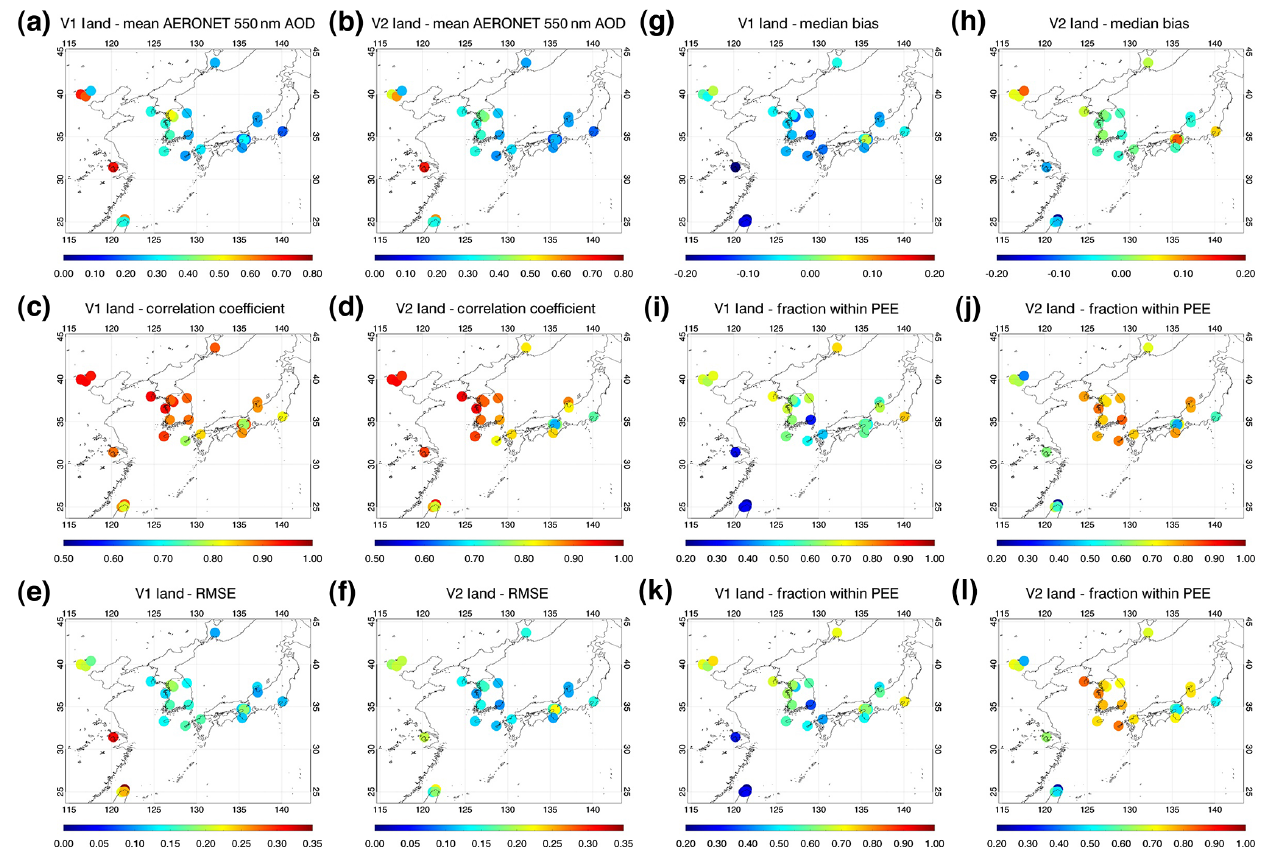
Figure 12. Spatial distribution of statistical evaluation metrics for GOCI YAER V1 QA3 land AOD (first and third columns) and V2 land AOD (second and fourth columns). Left panels show mean AERONET AOD, correlation coefficient, and RMSE from top to bottom. Right panels show median bias, fraction within DEE, and fraction within multiple PEE from top to